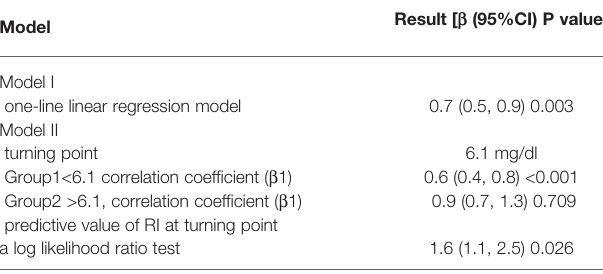
TABLE 3 | Threshold effect analysis of serum globulin level and the presence of RI using piece-wise linear regression. Model